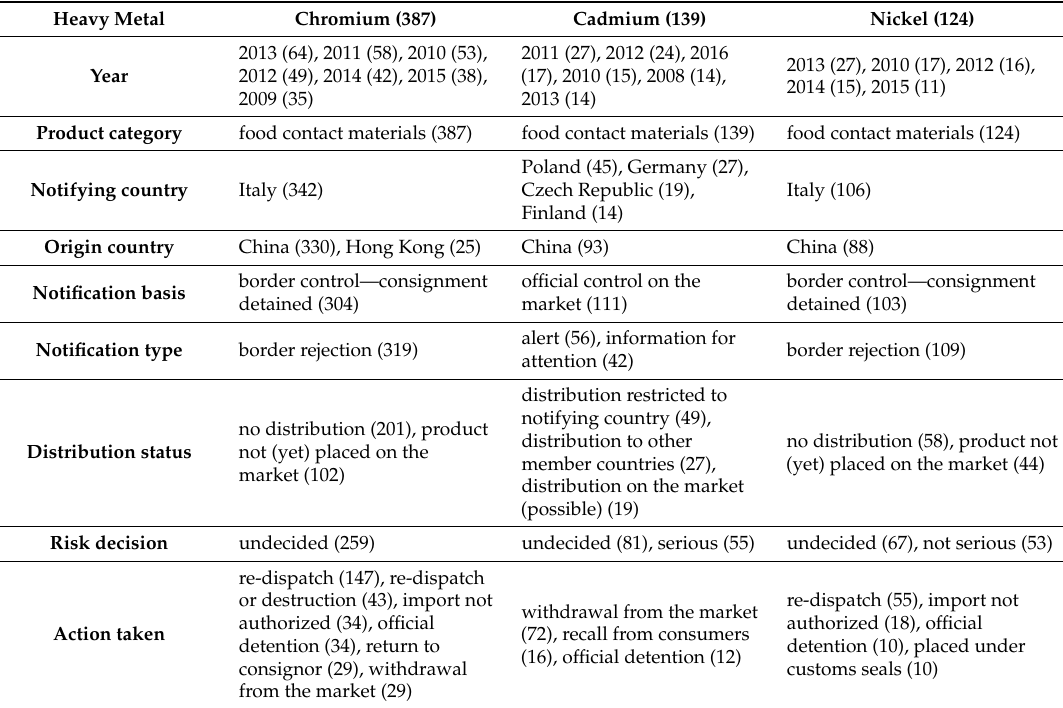
Table 2. Numbers of notifications of heavy metals within food contact